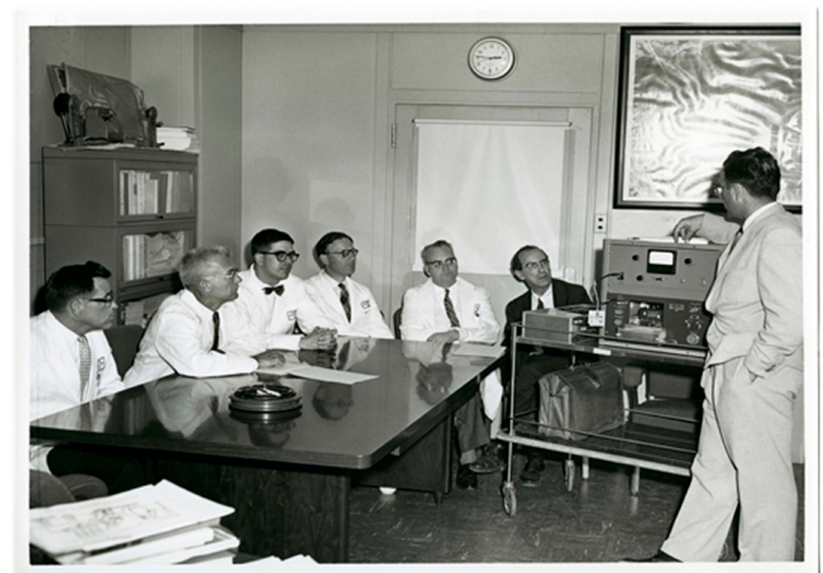
Figure 5. Meeting at the NIH in Bethesda in 1960. The second man from the left is George Z. Williams and the fifth man from the left Gunnar Jungner.